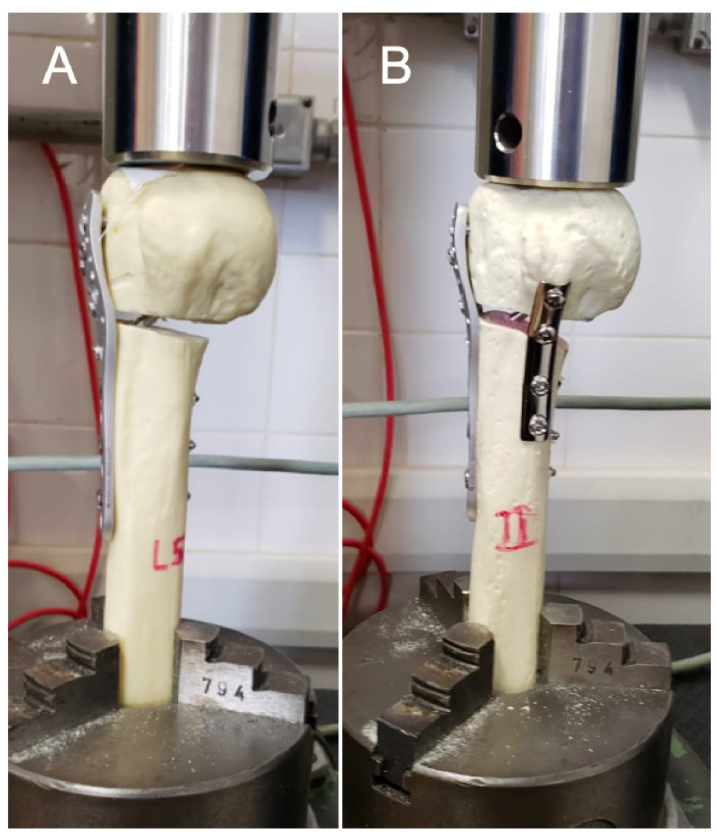
Fig 1. Mechanical testing. The distal portion of the bone models were cut in order to fit in the testing machine and positioned lengthwise to be tested in axial load for displacement rate. A–specimen of Group L, B–specimen of Group L